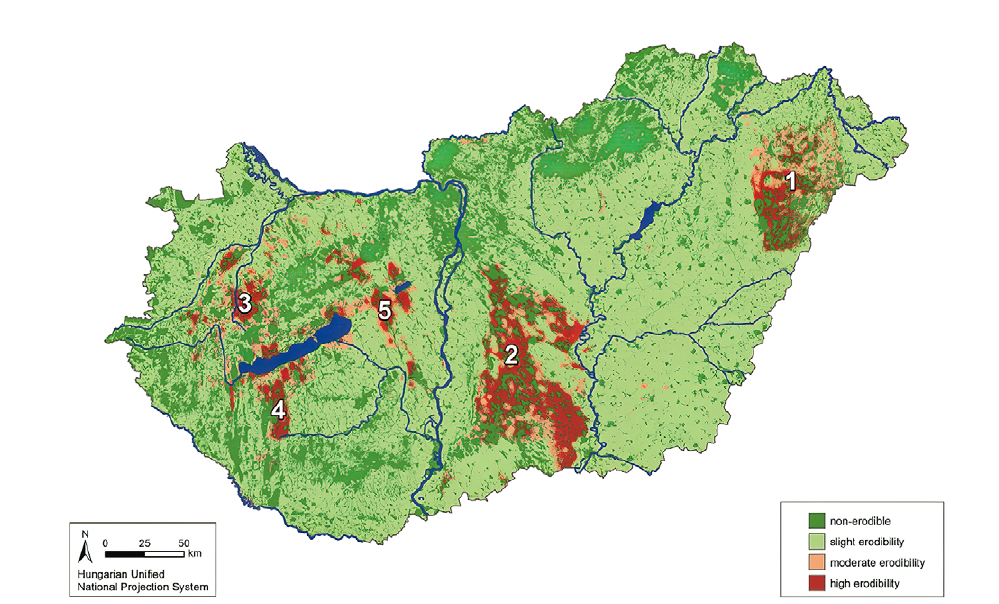
Figure 1. Wind erosion susceptibility map of the Hungarian soils. The five distinct areas: Nyírség (1), Danube–Tisza Interfluve (2), glacis in the foreground of the Transdanubian Mountains (3), Inner Somogy (4), Transdanubian loess region (5) (Pásztor et al.